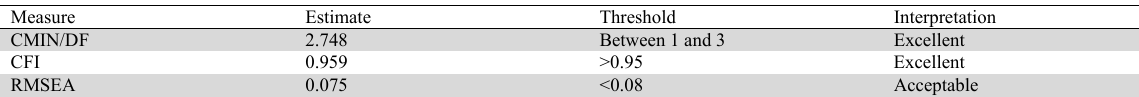
Model fit Measure